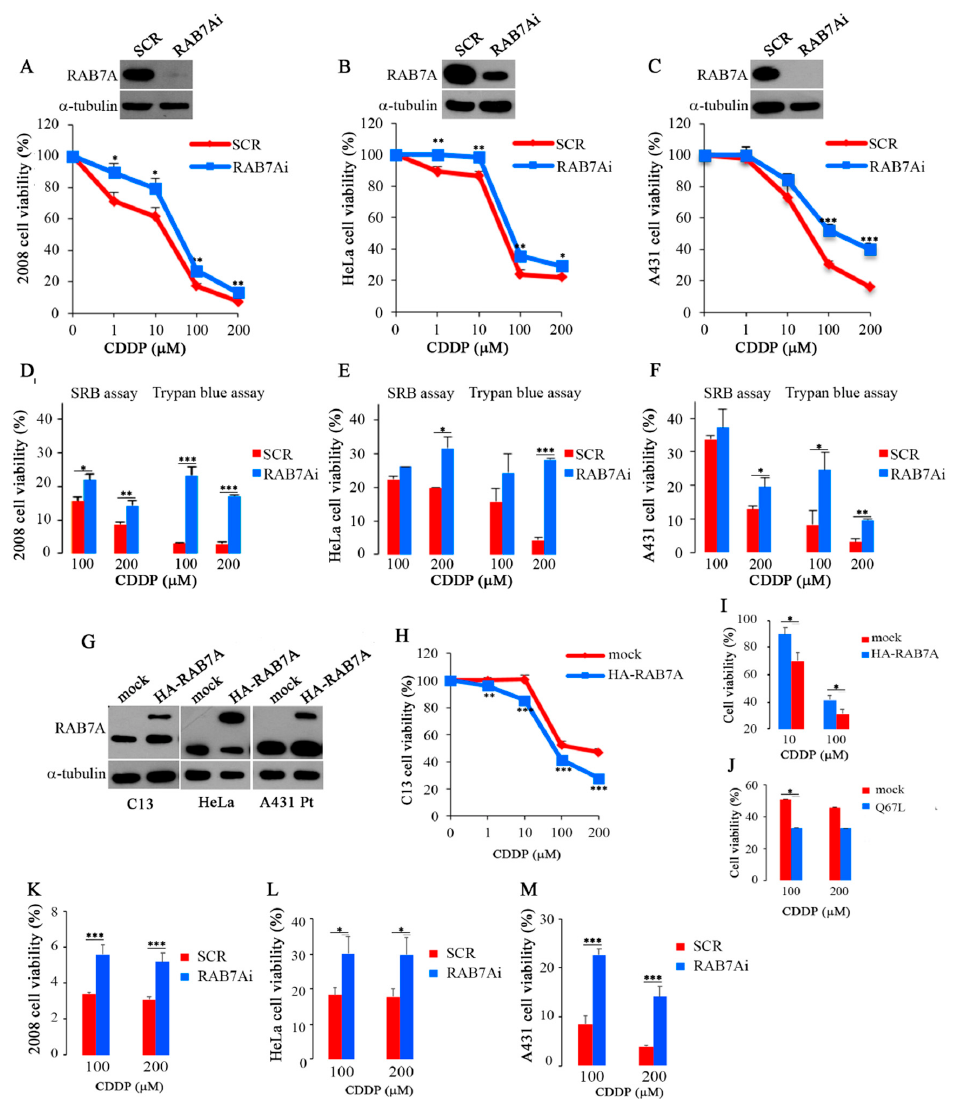
Figure 2. ( A – C ) MTT (3-(4,5-dimethylthiazol-2-yl)-2,5-diphenol tetrazolium bromide) and ( D – F